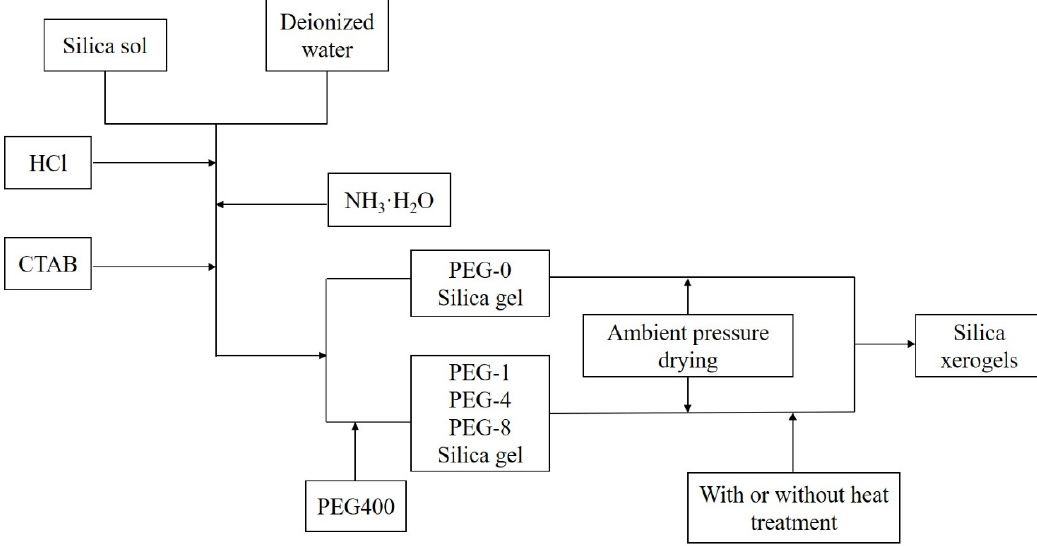
Figure 1. A schematic diagram of the experimental procedure.